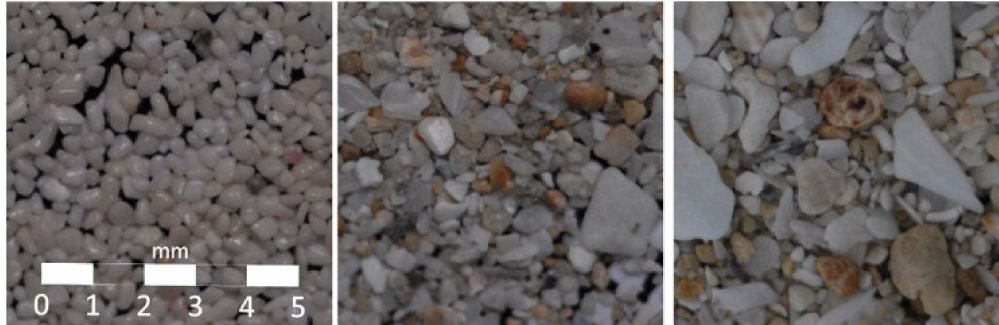
Figure 10. Left panel shows the native sand, 2004. Central and right panels, sand from the emerged and submerged beach fill, respectively.